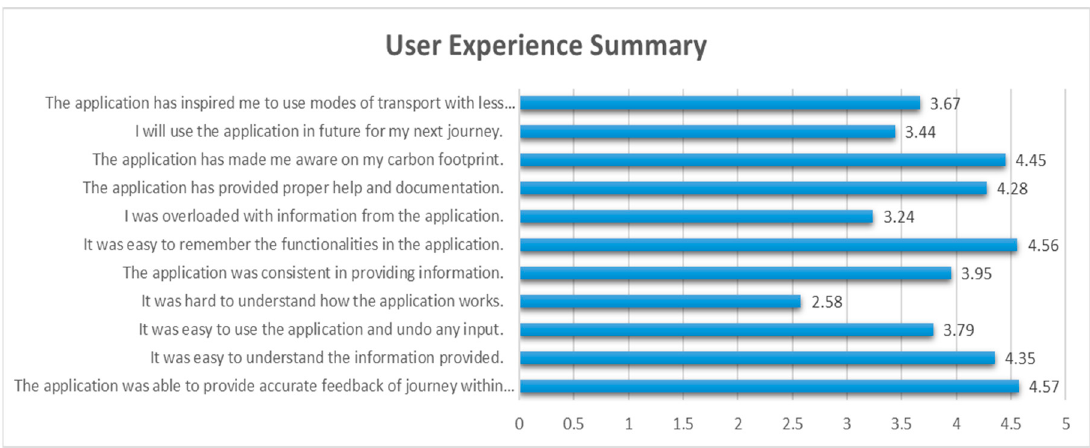
Figure 9. User experience summary on the usability of the application.